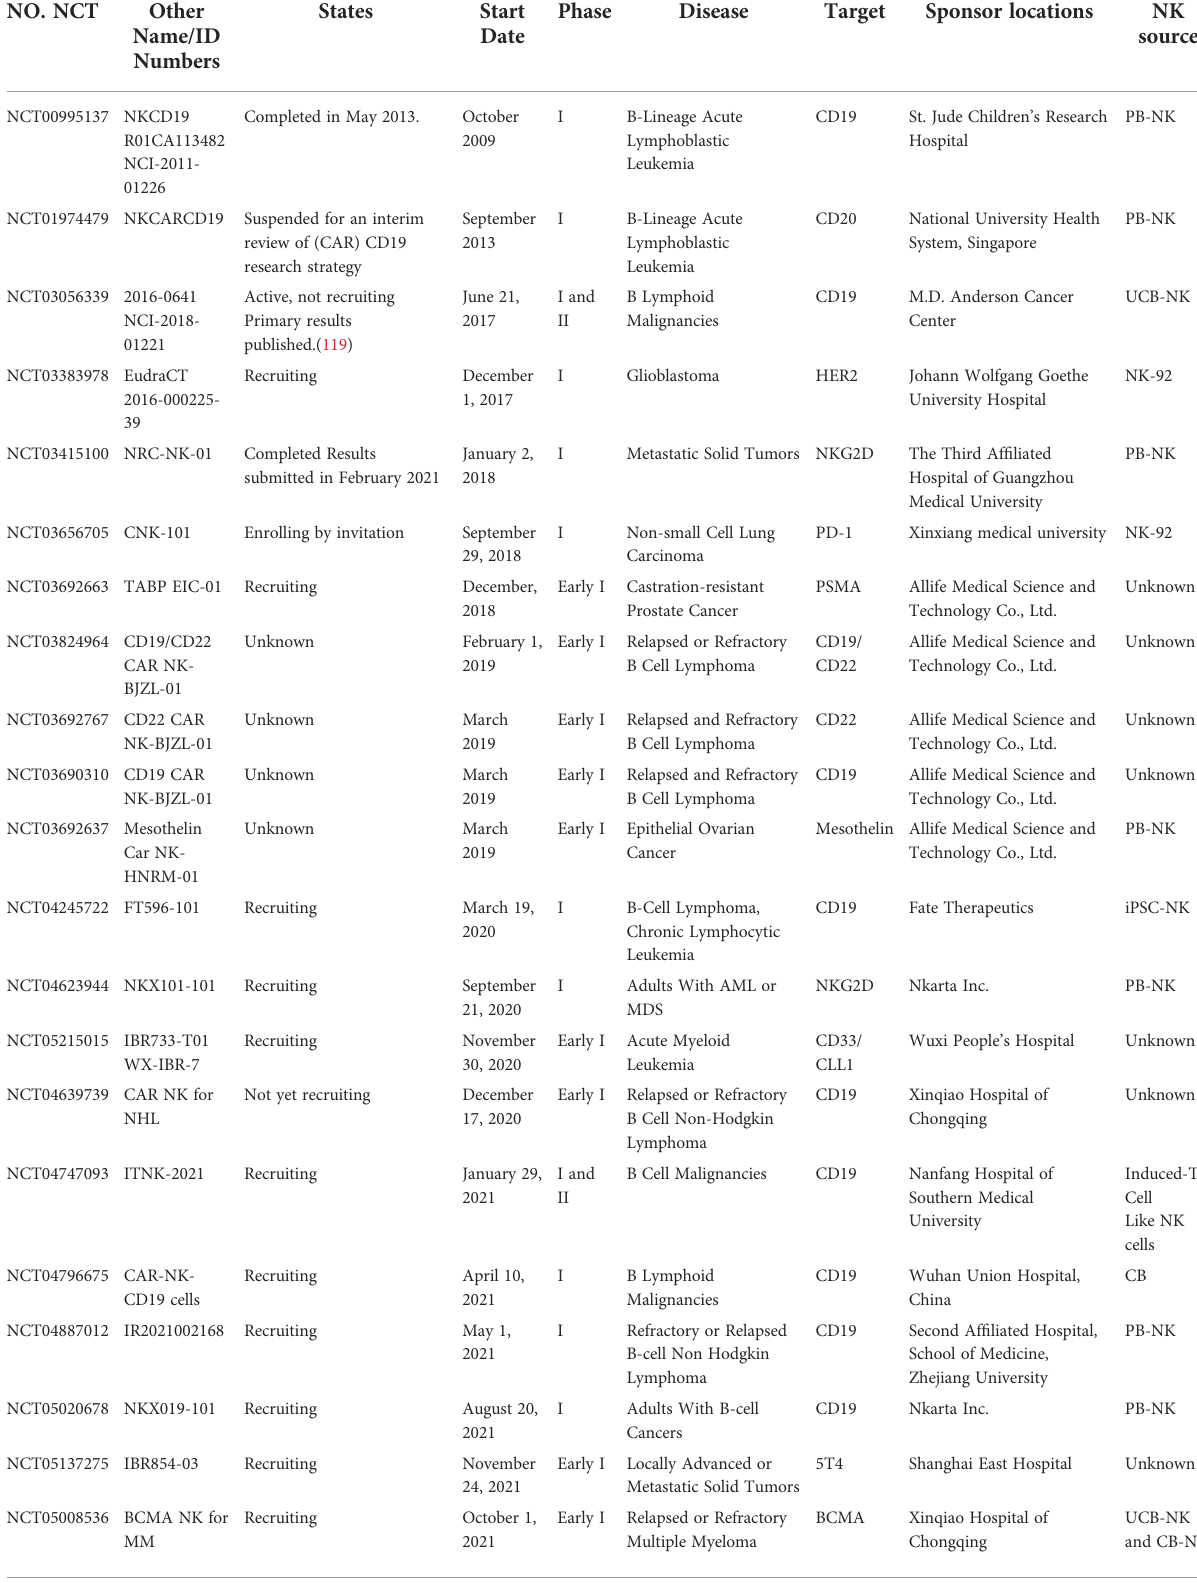
TABLE 2 Clinical trials for CAR-NK cell